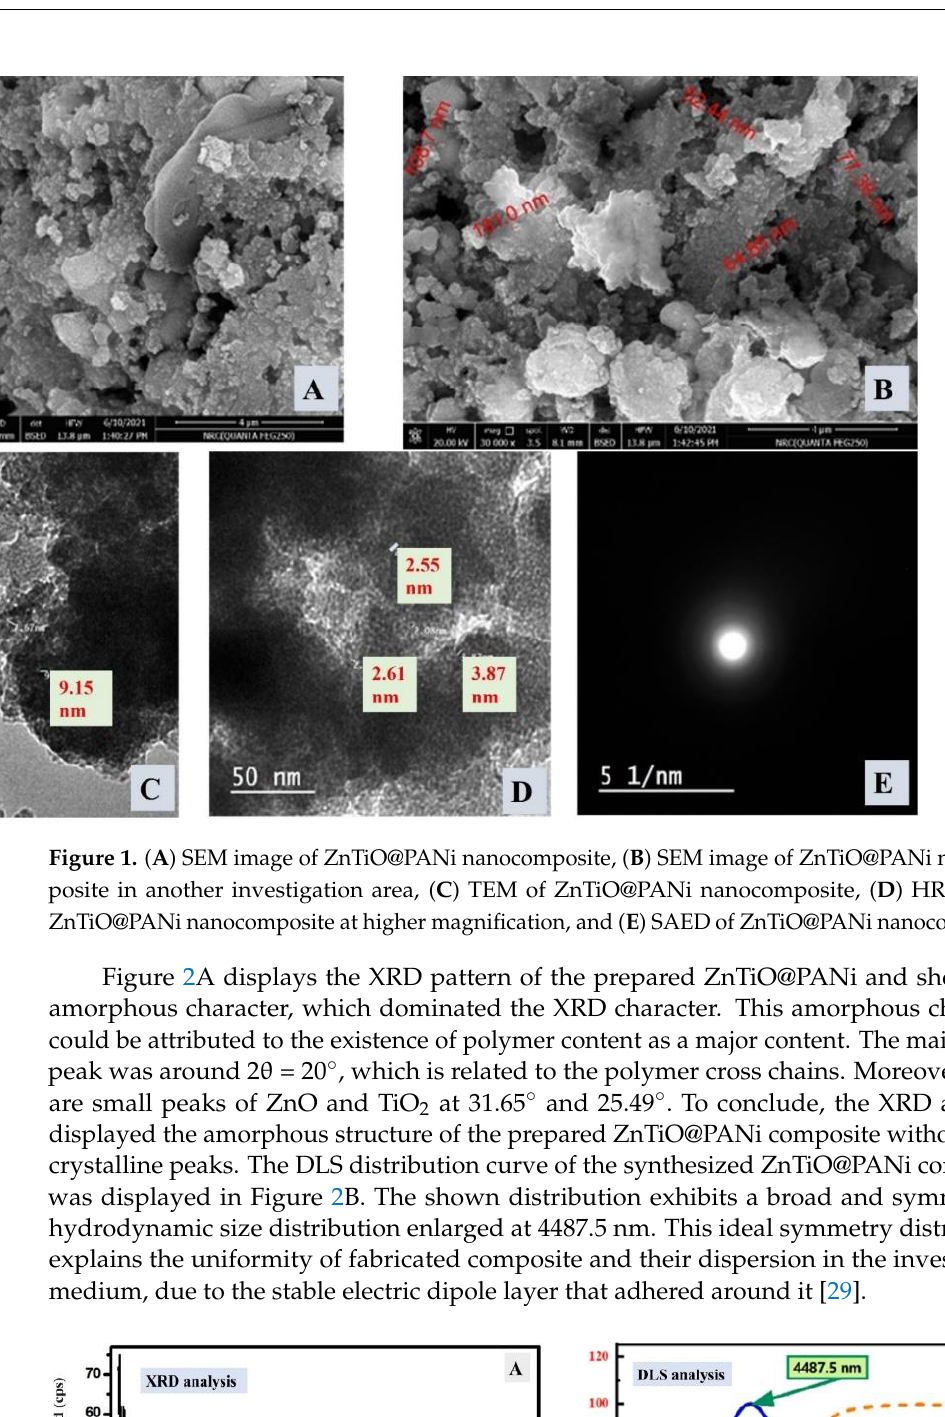
Figure 2. ( A ) XRD analysis of ZnTiO@PANi composite, ( B ) DLS analysis of ZnTiO@PANi nanocom- posite. 3.1.2. FT-IR and UV – Visible Spectroscopy